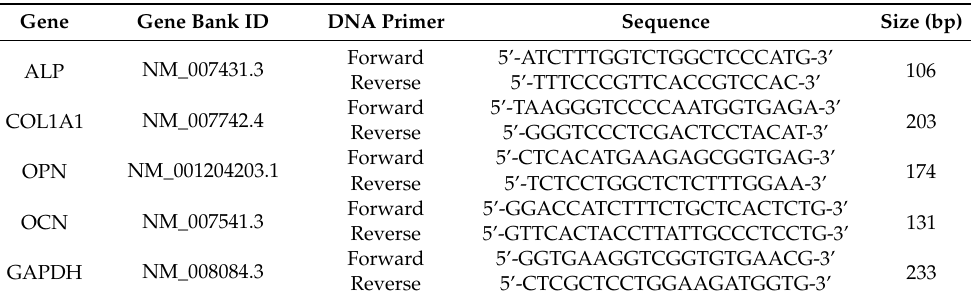
Table 2. Primers for osteogenesis-related